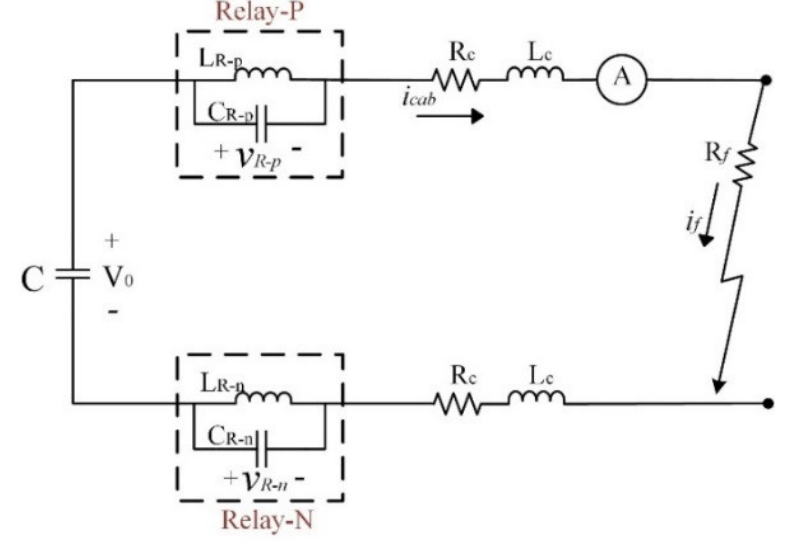
Figure 16. LC based Overcurrent relay [90].